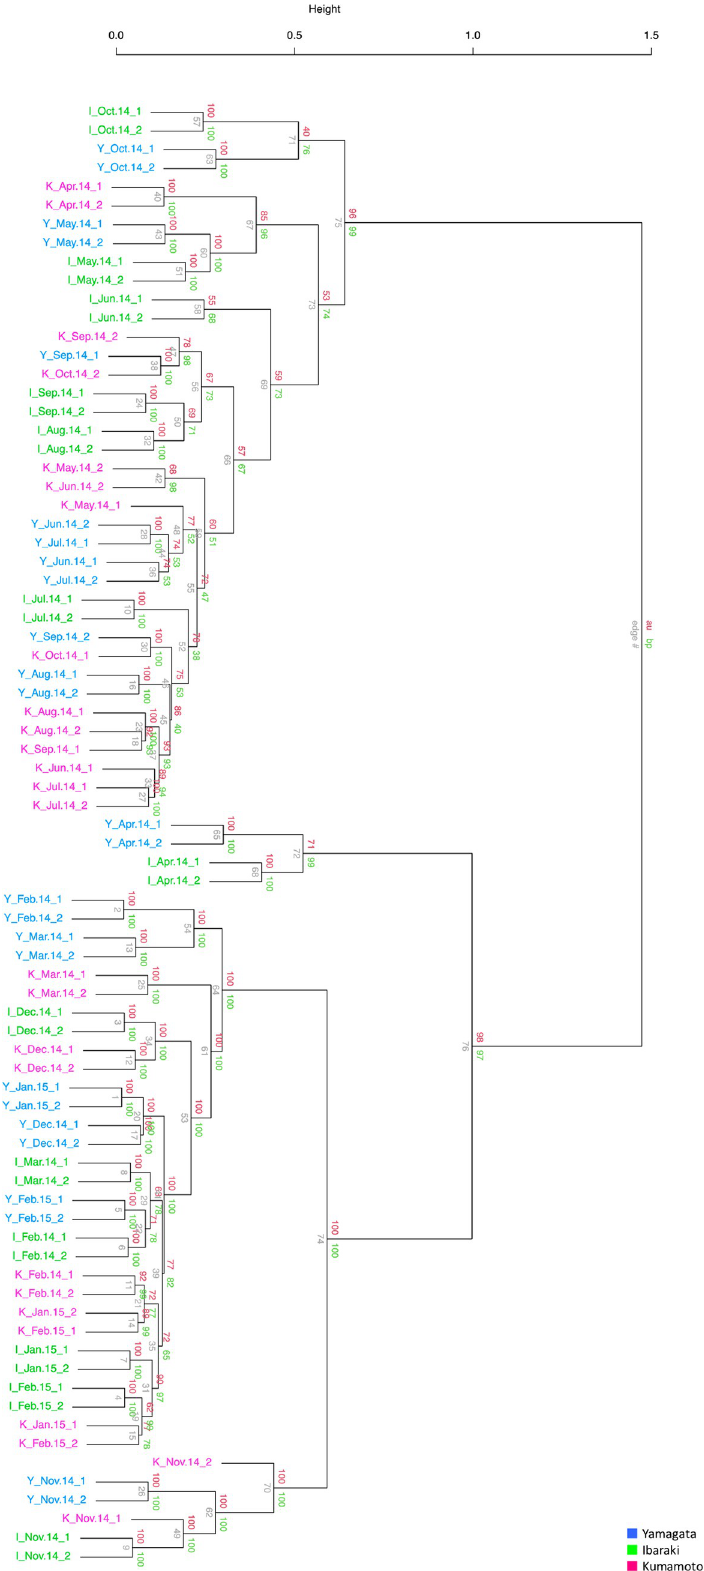
Fig 3. Hierarchical clustering of 78 samples collected from the three sites throughout a 1-year period. https://doi.org/10.1371/journal.pone.0277797.g003 PLOS ONE | https://doi.org/10.1371/journal.pone.0277797 February 16,